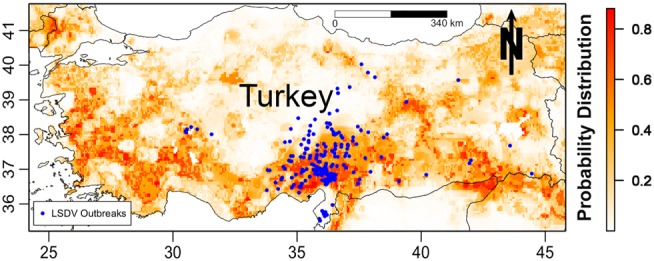
Probability of spatial distribution of lumpy skin disease virus (LSDV) in cattle in Turkey predicted by the Israeli Maxent model (II). The figure is a magnified snap shot for Turkey in Figure 3B. The blue dots represent the observed geographical distribution of LSDV in Turkey.